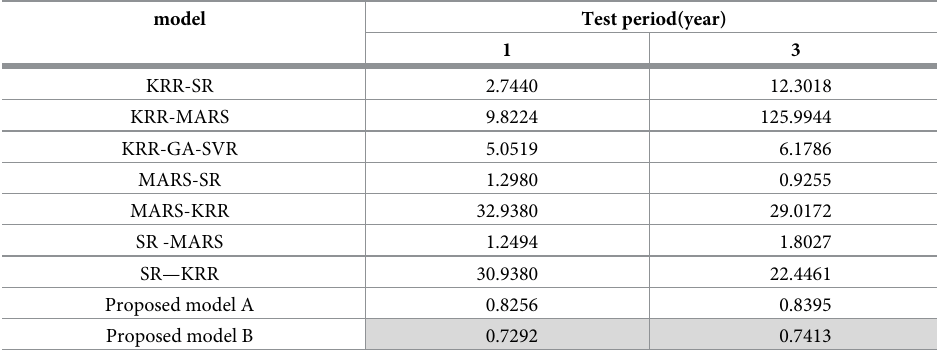
Table 12. Performance comparisons for TSMC.